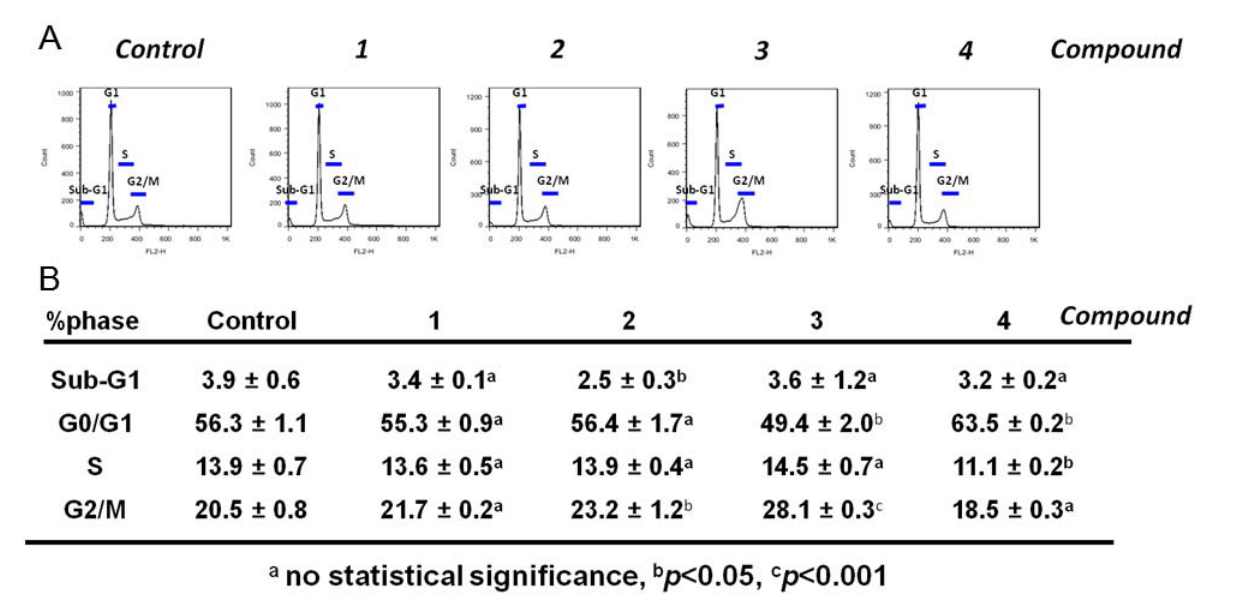
Figure 3. Effects of L. tulipifera compounds on cell cycle progressions of melanoma A375.S2 cells. A375.S2 cells were treated with the 100 μ M of four compounds for 24 h, respectively. ( A ) Among these four compounds-treated cells, an accumulation of G population in compound 3 -treated A375.S2 cells was observed. ( B ) The quantification